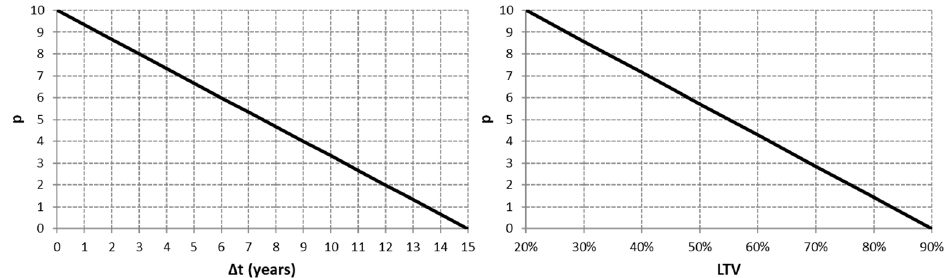
Figure 2. Trend of the preference functions for the ∆𝑡 and the 𝐿𝑇𝑉 criteria.